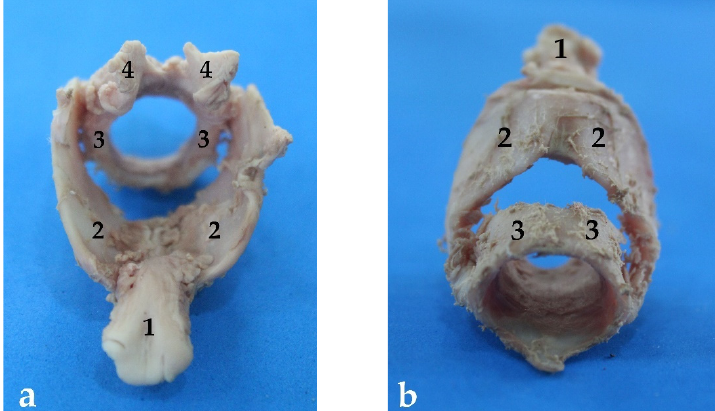
Figure 4. Larynx cartilaginous structure of Arctocephalus australis : ( a ) rostral view, ( b ) caudal-ventral view, (1) epiglottis, (2) thyroid cartilage, (3) cricoid cartilages, (4) arytenoid cartilages. 3.5. Trachea